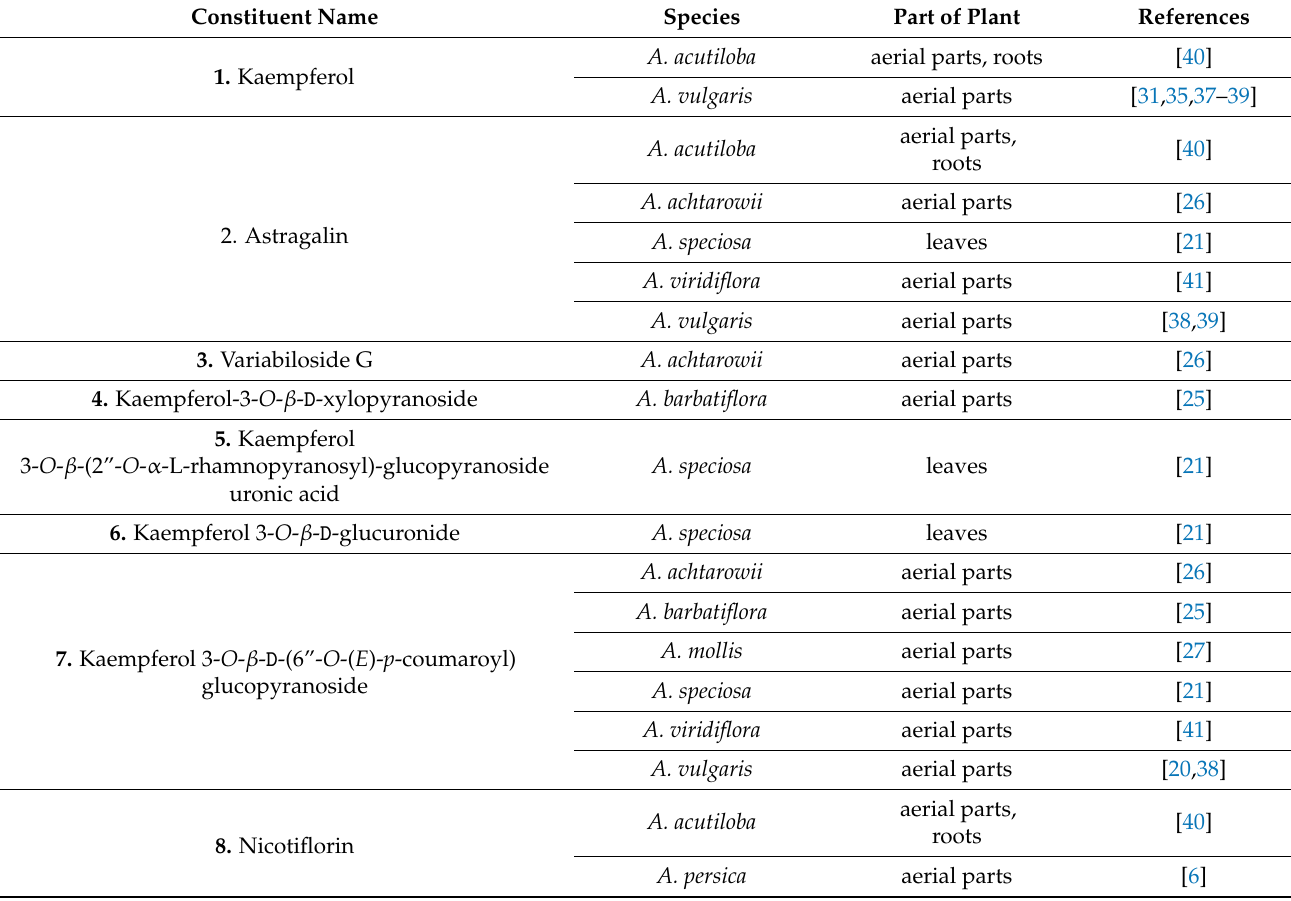
Table 7. The overview on the phenolic compounds identified in the Alchemilla